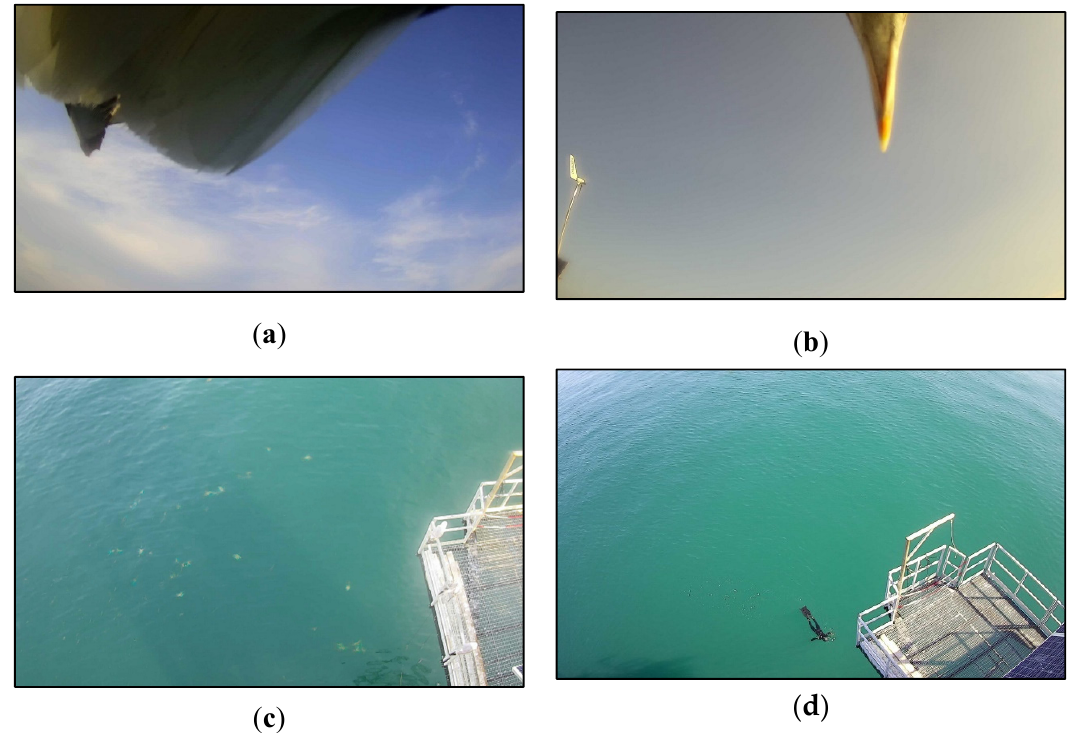
Figure 5. Sample photos taken from the camera aligned with the radiance sensor (for azimuth angles not used for measurements in this paper). ( a ) Bird blocking field of view; ( b ) more subtle measurement contamination; ( c ) floating vegetation and platform shadow on water; ( d ) unexpected water target contamination.